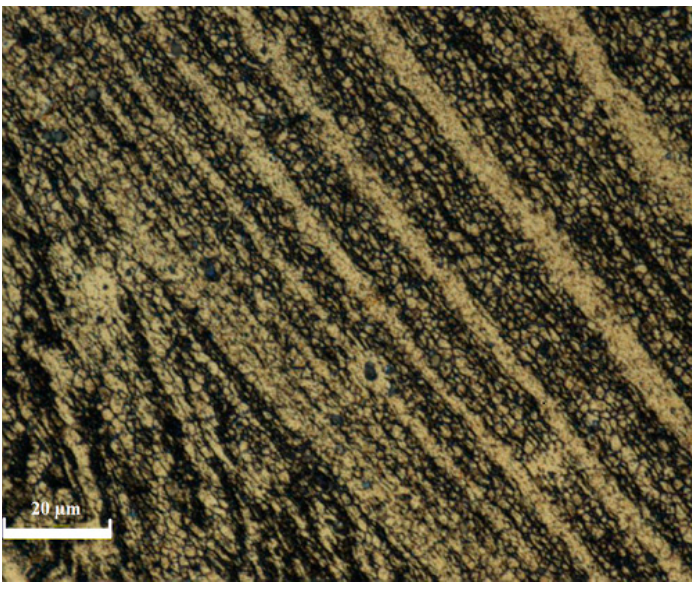
Figure 4. Magnified view of the zone containing ORs in sample T4.